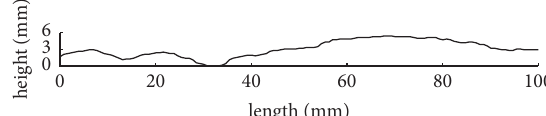
Figure 4: Schematic diagram of standard joint contour line